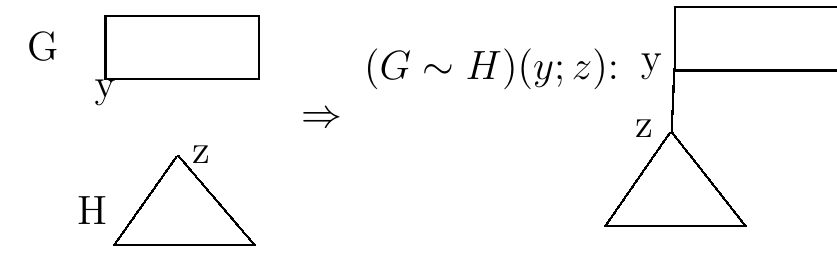
Figure 4. The link of G and H by vertices y and z